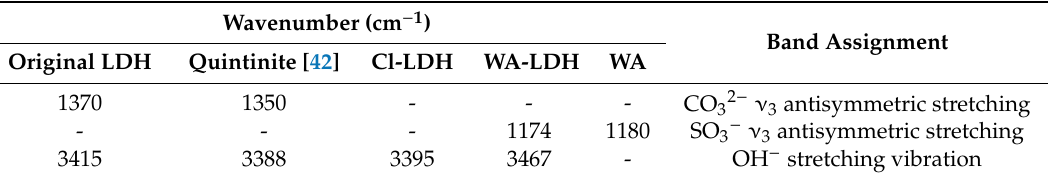
Table 3. Infrared bands observed for unmodified LDH, Cl-LDH, and WA-LDH compared to the literature data.